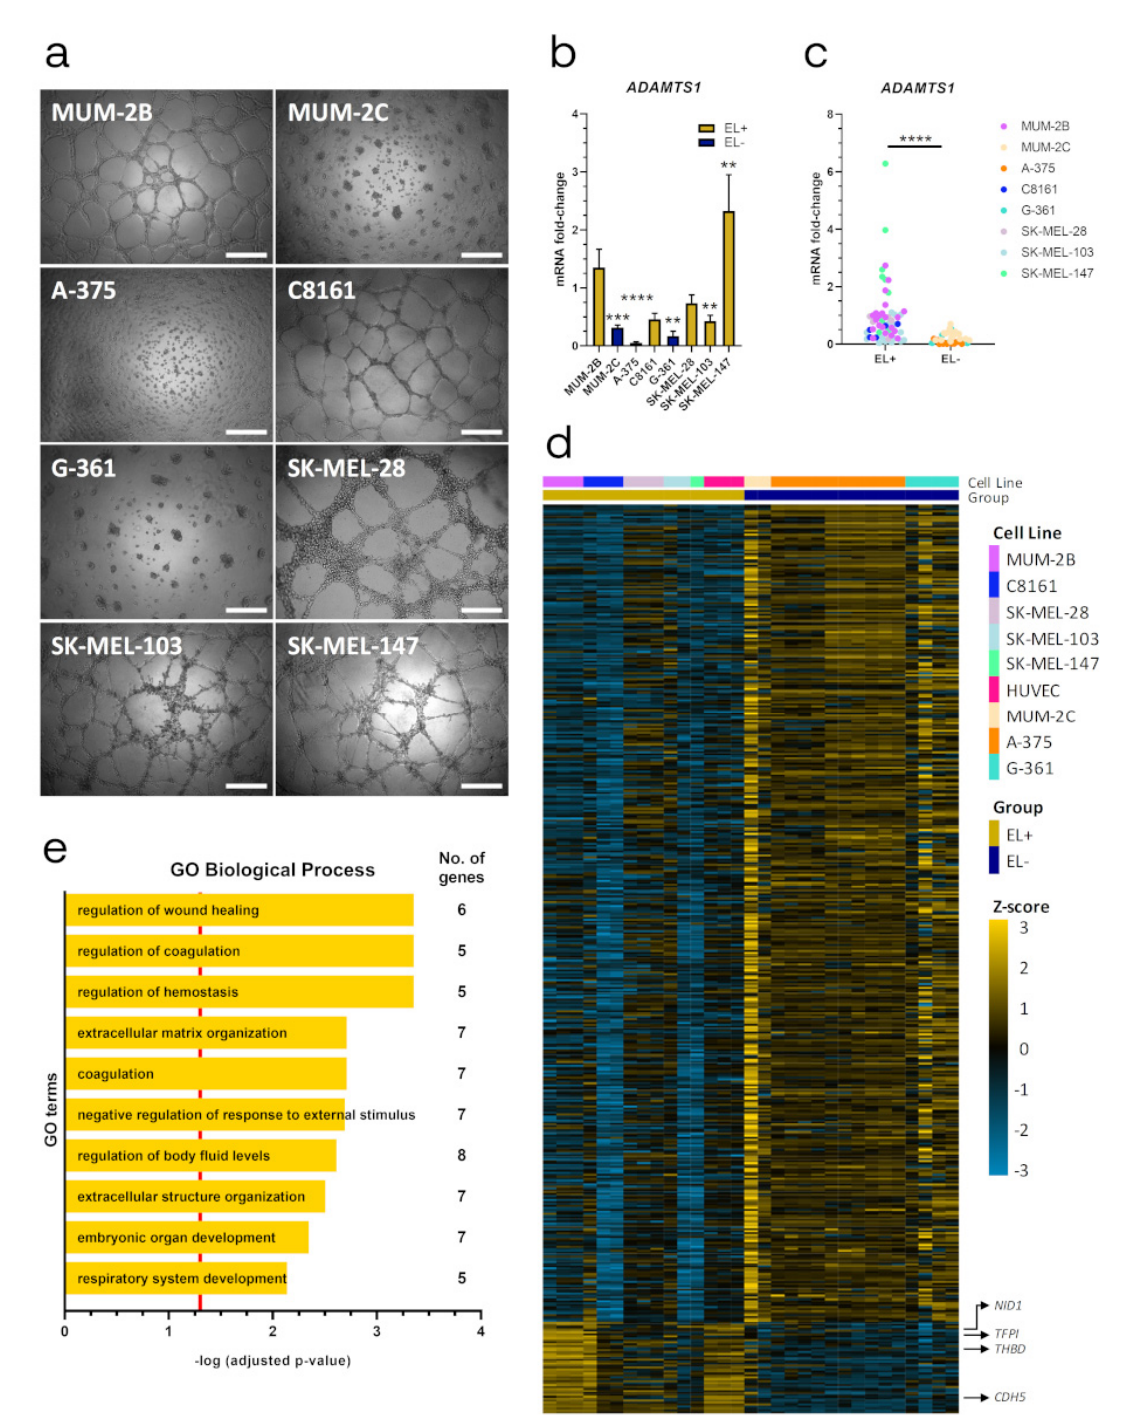
Figure 1. Endothelial-like properties of melanoma cells and correlation with ADAMTS1 expression. ( a ) Representative images of 3D Matrigel-based assay of human melanoma cell lines, 24 h after seeding. 20,000 cells/well were cultured for MUM-2B, SK-MEL-147, C8161, MUM-2C and SK-MEL-103; and 30,000 cells/well for SK-MEL-28, G-361 and A-375 (white scale bar = 500 µm); ( b ) Graph representing mRNA fold change expression of ADAMTS1 in human melanoma cell lines. Values are relative to MUM-2B ( n = 21 for MUM-2B, n = 17 for MUM-2C, n = 11 for A-375, n = 5 for C8161 and SK-MEL-28, n = 6 for G-361, n = 15 for SK-MEL-103 and n = 9 for SK-MEL-147). EL+ and EL- phenotypes are indicated; ( c ) Graph representing mRNA fold change expression of ADAMTS1 in